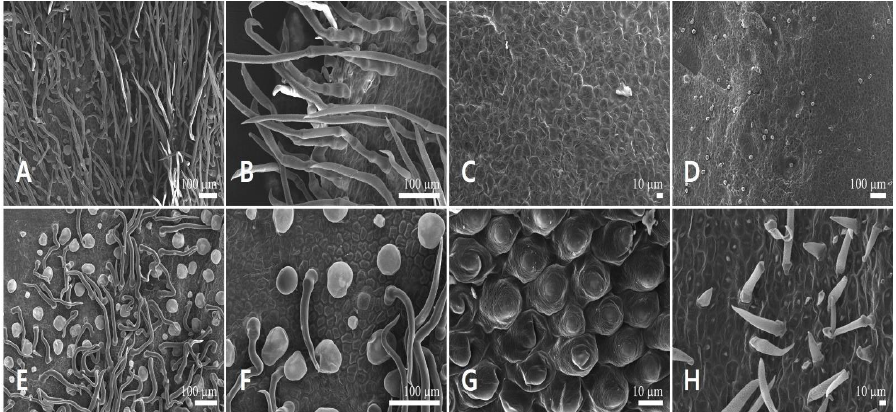
Figure 7. Scanning electron micrographs of the corolla epidermis in Leonurus macranthus . ( A , B ) Abaxial side of the upper lip. ( C , D ) Adaxial side of the upper lip. ( E , F ) Abaxial side of the lower lip. ( G , H ) Adaxial side of the lower lip. All epidermal cells of the anther were isodiametric, polygonal with depressed, sinuous AW (Figure 8A,B). The outer PW of the adaxial and abaxial sides was convex (Figure 8A), whereas that of the apical part was conical (Figure 8B). The epidermal cells of the filament were isodiametric, elongated to tetragonal with depressed, straight AW, and convex PW